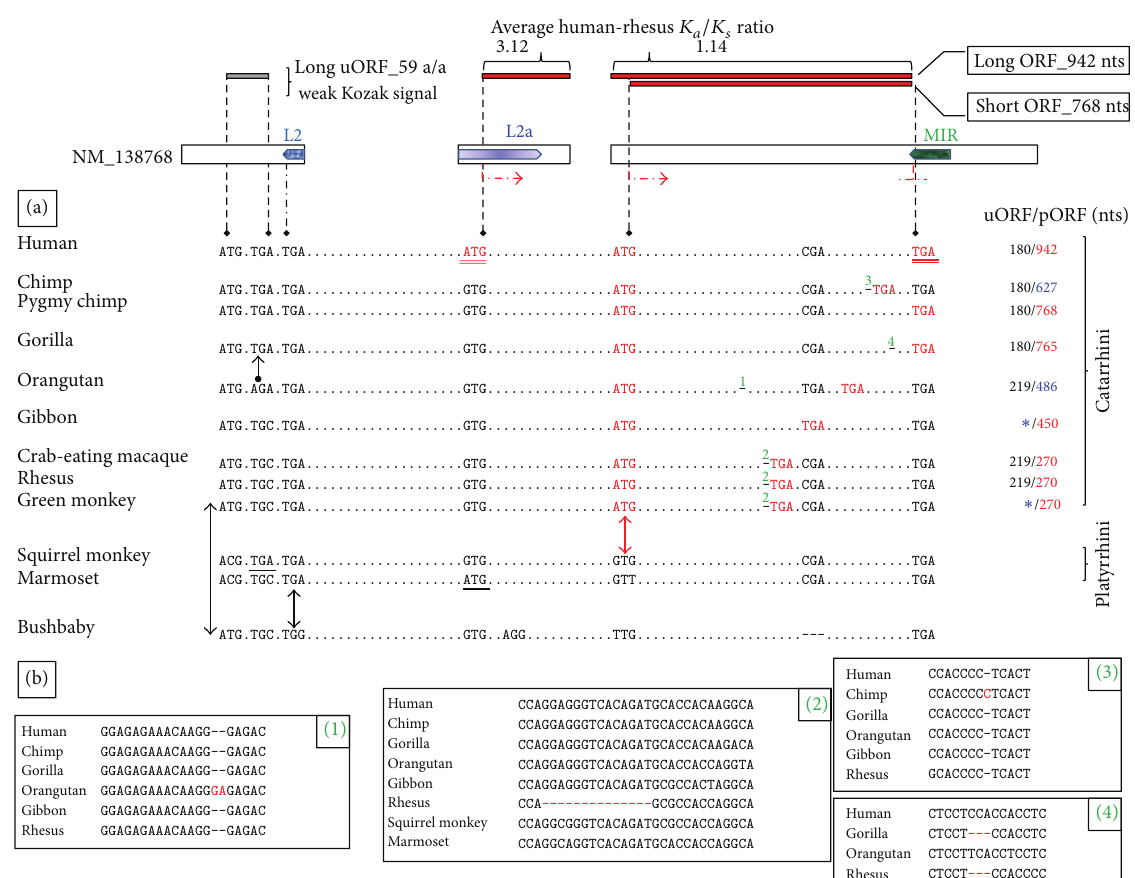
Figure 2: From a noncoding sequence to MYEOV . Depicted is MYEOV transcript variant 2 (NM 138768) as described in Figure 1; illustrated are both the translatable ORFs (red horizontal bars) and the long uORF (dark-grey horizontal bar) present in the variant. Shown also are the averagehuman-rhesus 𝐾 𝑎 /𝐾 𝑠 ratioscalculatedseparatelyfor MYEOV secondandthirdexoncodingDNAsequences.(a)Black,discontinuous, vertical lines point to precious trinucleotides of MYEOV sequence, referred to within the text. Appearing underlined, in red font, are the trinucleotides that demarcate MYEOV-313 coding sequence. Aligned below the human sequence are corresponding trinucleotides from MYEOV syntenic region in 11 primates. Bona fide pORFs in MYEOV orthologs are delimited by respective red font trinucleotides; out- of-frame stop codons are presented unaligned. Double-headed red arrow points to the de novo acquisition of MYEOV-255 start codon in Catarrhini. MYEOV-313 start signal is human-specific; an identical ATG trinucleotide appearing in marmoset syntenic region (underlined) is due to a parallel mutation. Double-headed black arrows are for the trinucleotides demarcating the primal 219 nts long uORF that arose in Catarrhini. A black directional arrow points out the shortening of this long uORF in Hominines; an identical TGA trinucleotide occurring in squirrel monkey syntenic region (underlined) is likely due to a parallel mutation. Shown in the right flank is the size of the long uORF/pORF corresponding to each species. The sizes of the pORFs present in chimpanzee and Sumatran orangutan MYEOV orthologs (appearing in blue font) require decidedly additional validation due to the presence of ORF-shifting indels in the respective sequences. Blue asterisks for gibbon- and green monkey-specific indels that transmute the respective uORFs. Alignment gaps in bushbaby syntenic region were inserted for clarity. (b) Provided within boxes, numbered in accordance with the superscripts numbers appearing in (a), are syntenic alignments among various higher primates including the indels referred to in the text. With regard to the Cercopithecoidea-specific 14bp deletion, shown is only one of these species due to space